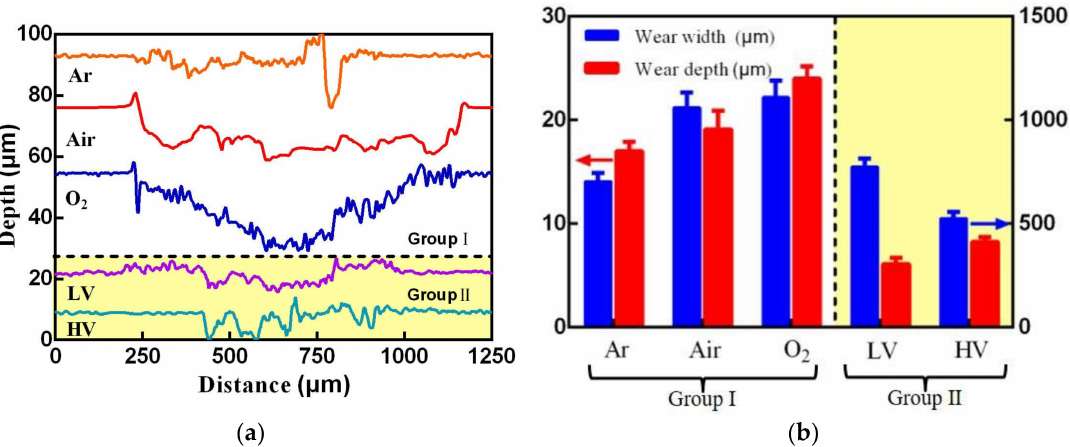
Figure 3. The profile micrographs of wear scars ( a ) and the corresponding wear width and wear depth ( b ) under different atmosphere and vacuum